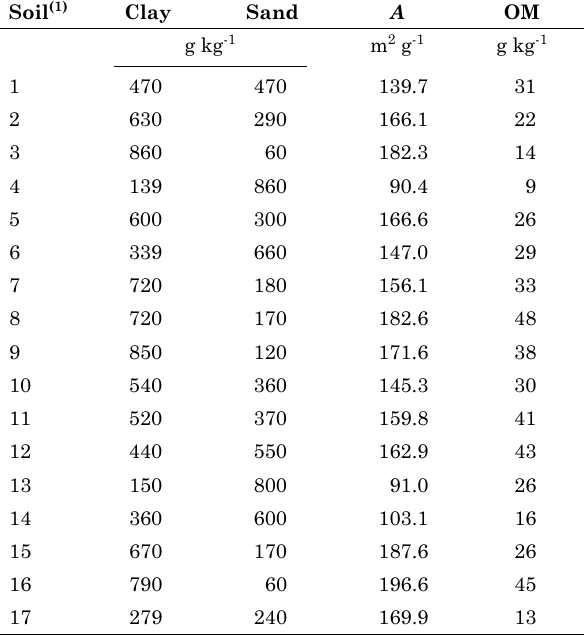
table 2. Soil granulometry, surface area ( A ), and organic matter content (om) from